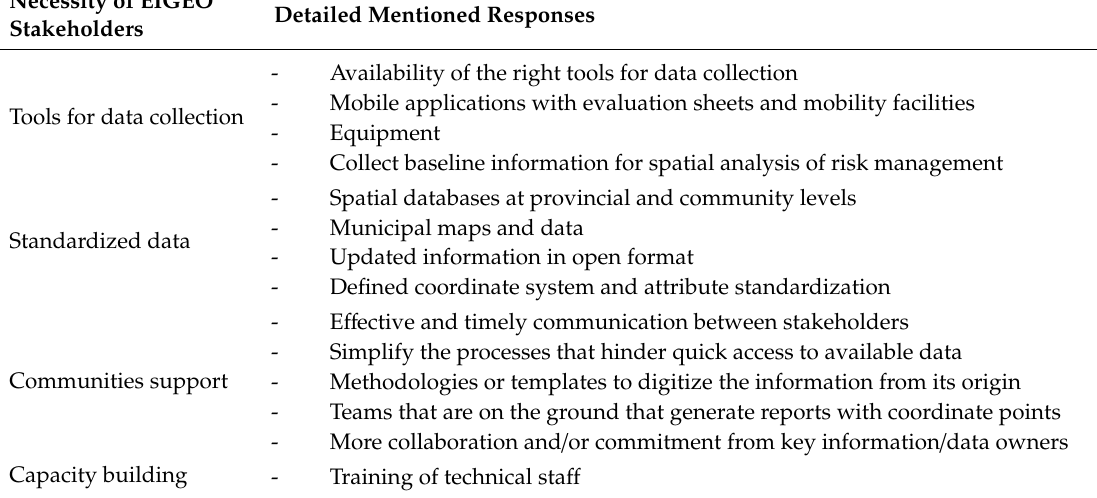
Table 1. Necessity of EIGEO stakeholders regarding information gathering (Q12) .